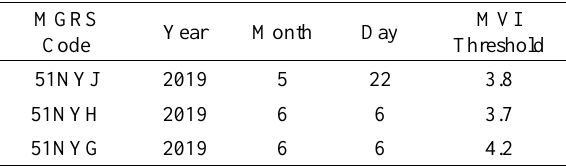
Table 1 . Suggested minimum threshold for the missed tiles in the 2019 Mangrove Extent Map of the Philippines.